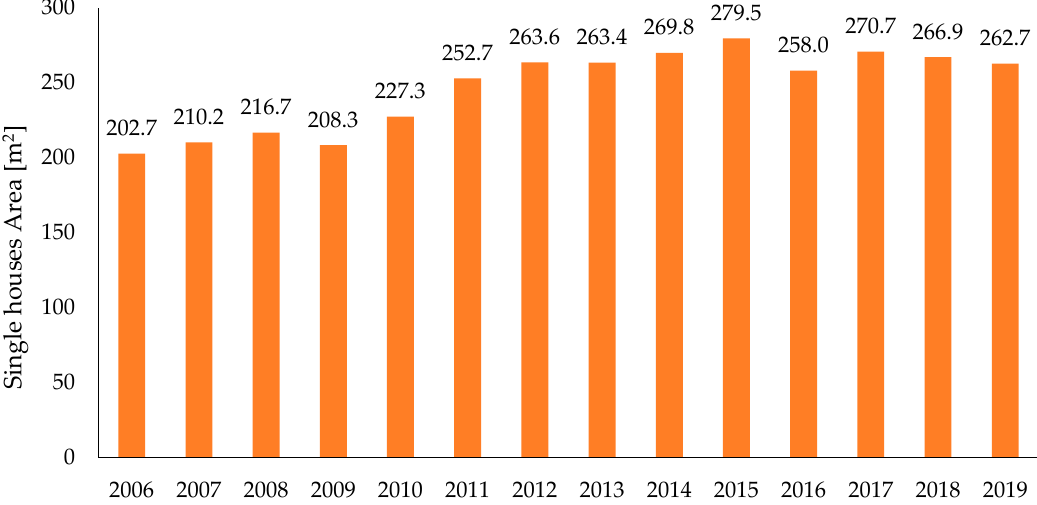
Figure 2. New residential dwellings, single houses average area per year, derived from CyStat [36].